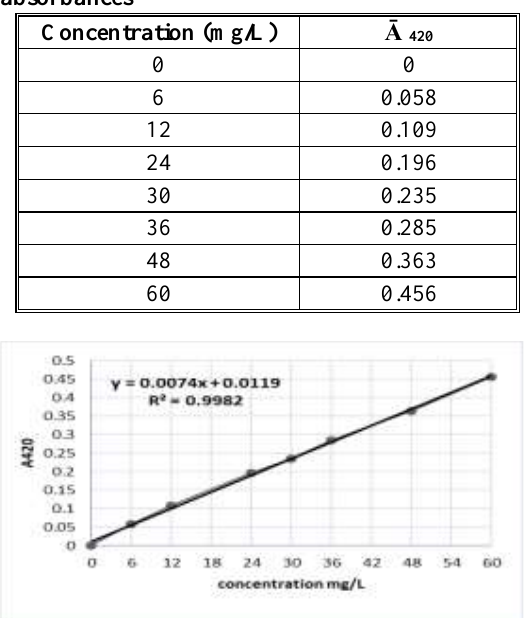
Figure 5. Quercetin calibration curve TFC of the extracts Flavonoids content in the extracts is also presented in Table (5). As the methanolic extract showed the highest phenolic amount, it contained the highest flavonoid content (38.9 mg QE/ g DE), followed by MeOH: EtOAc (1:1), EtOH 50%, DH 2 O and CHCl 3 extracts, respectively. The TFC results are shown in Figure